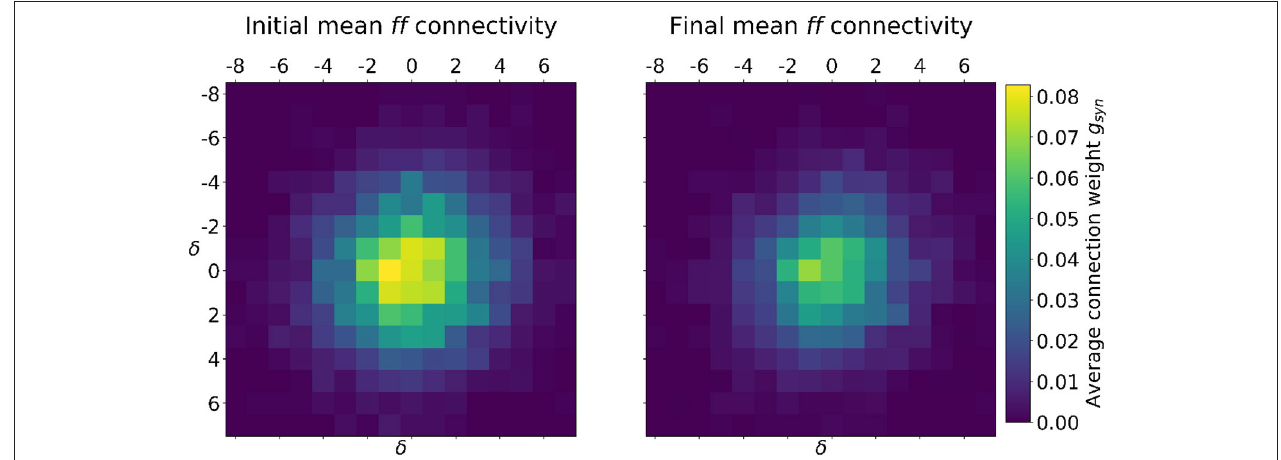
FIGURE 5 | Example Case 2 initial (Left) and final (Right) distributions of mean weight at discrete relative distances from individual neurons. STDP sharpens the receptive field by depressing synapses far from stimulus centers. For reference, the initial connectivity (Left) started with a σ aff − init = 2.35 and an AD init = 0.81, values which were refined by the end of the simulation (Right) to σ aff − weight = 1.92 and an AD weight = 0.79. Table 2 contains additional reported parameters.